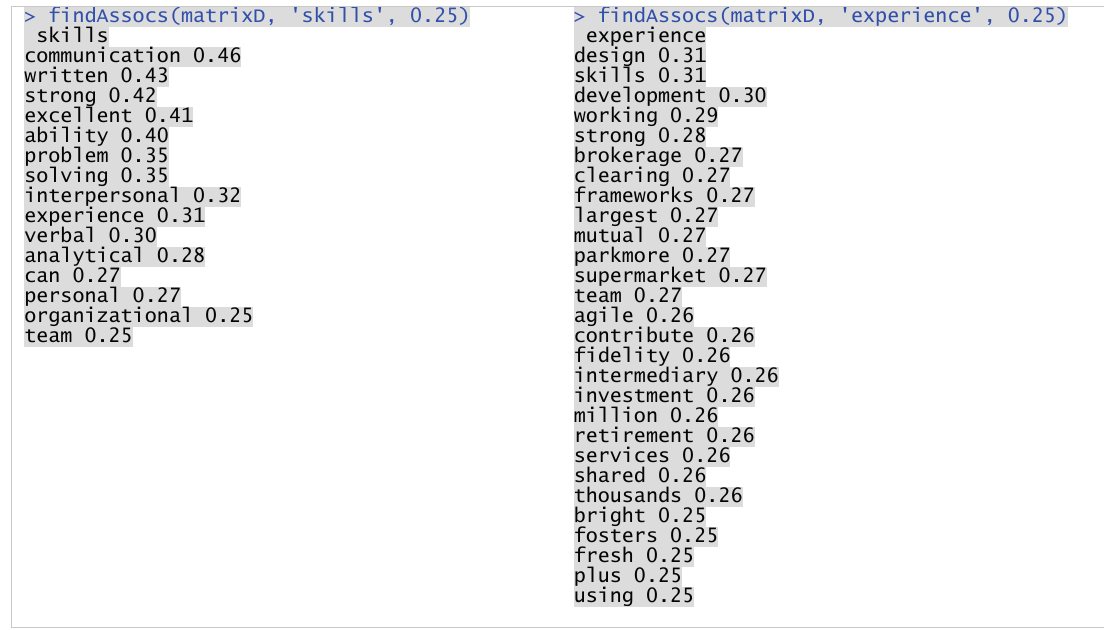
Figure 6. Selected terms associations within